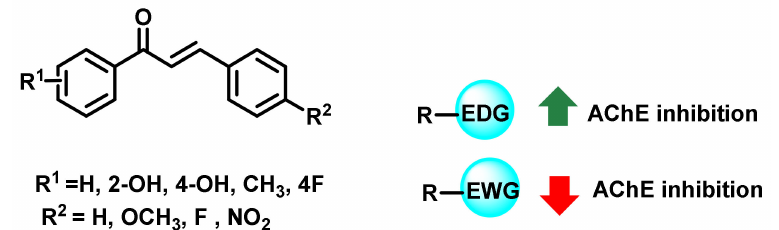
Figure 4. Chalcone derivatives with simple substitutions by Aslan et al.